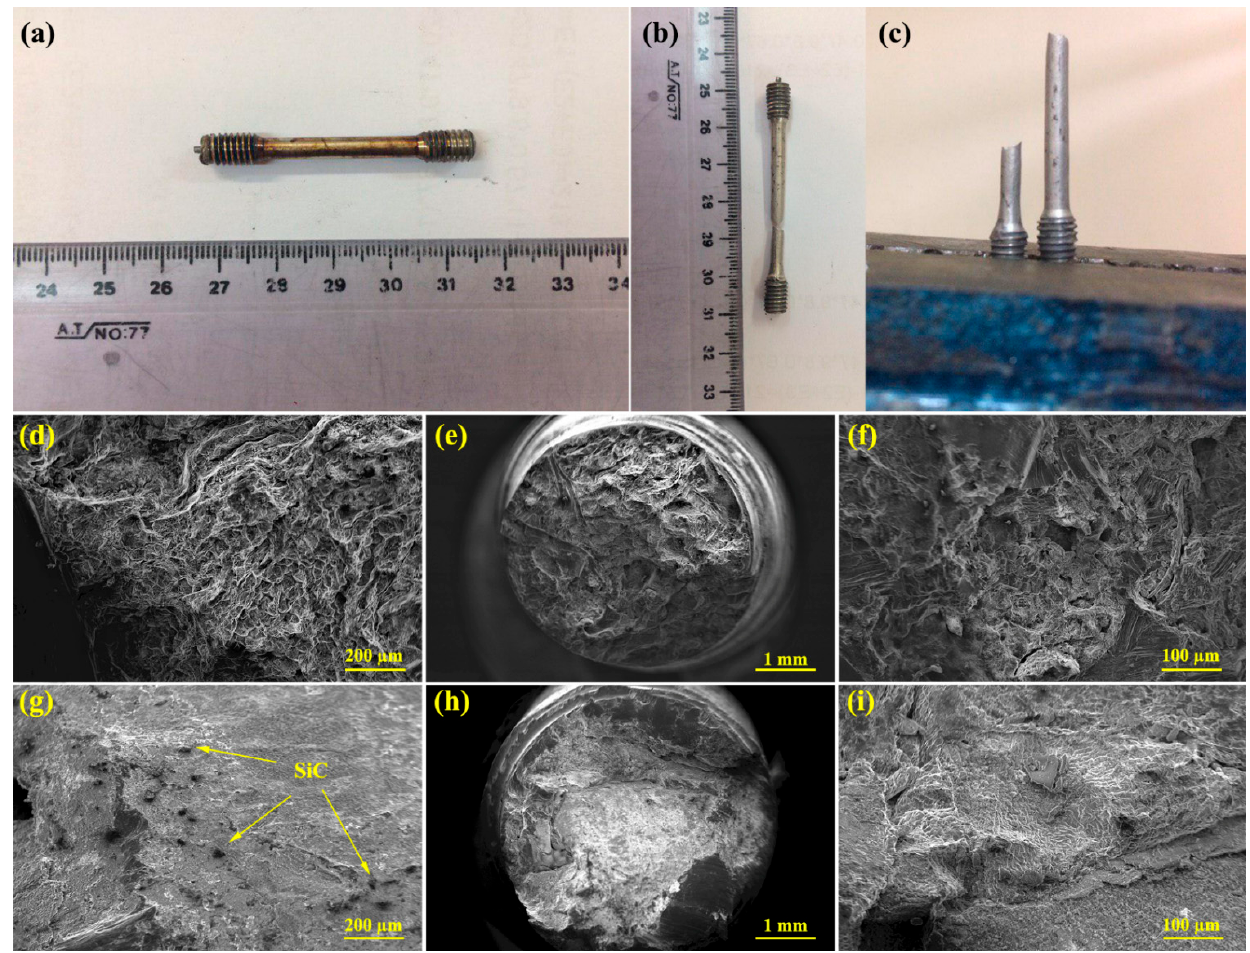
Figure 15. ( a ) Sample before creep test, ( b , c ) fracture sample after creep test, ( d – f ) fracture surfaces of the unreinforced alloy after creep test at 150 °C under 30 MPa stress, and ( g – i ) fracture surfaces of the ZK60/SiC p composite after creep test at 150 °C under 30 MPa stress.